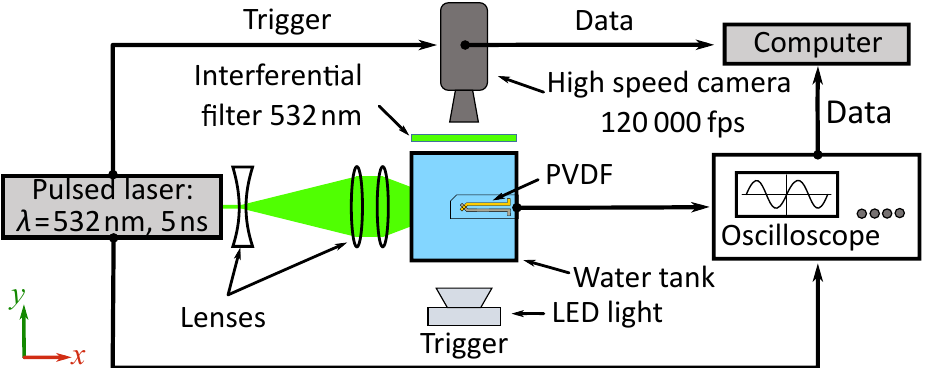
Figure 1. Schematics of the experimental